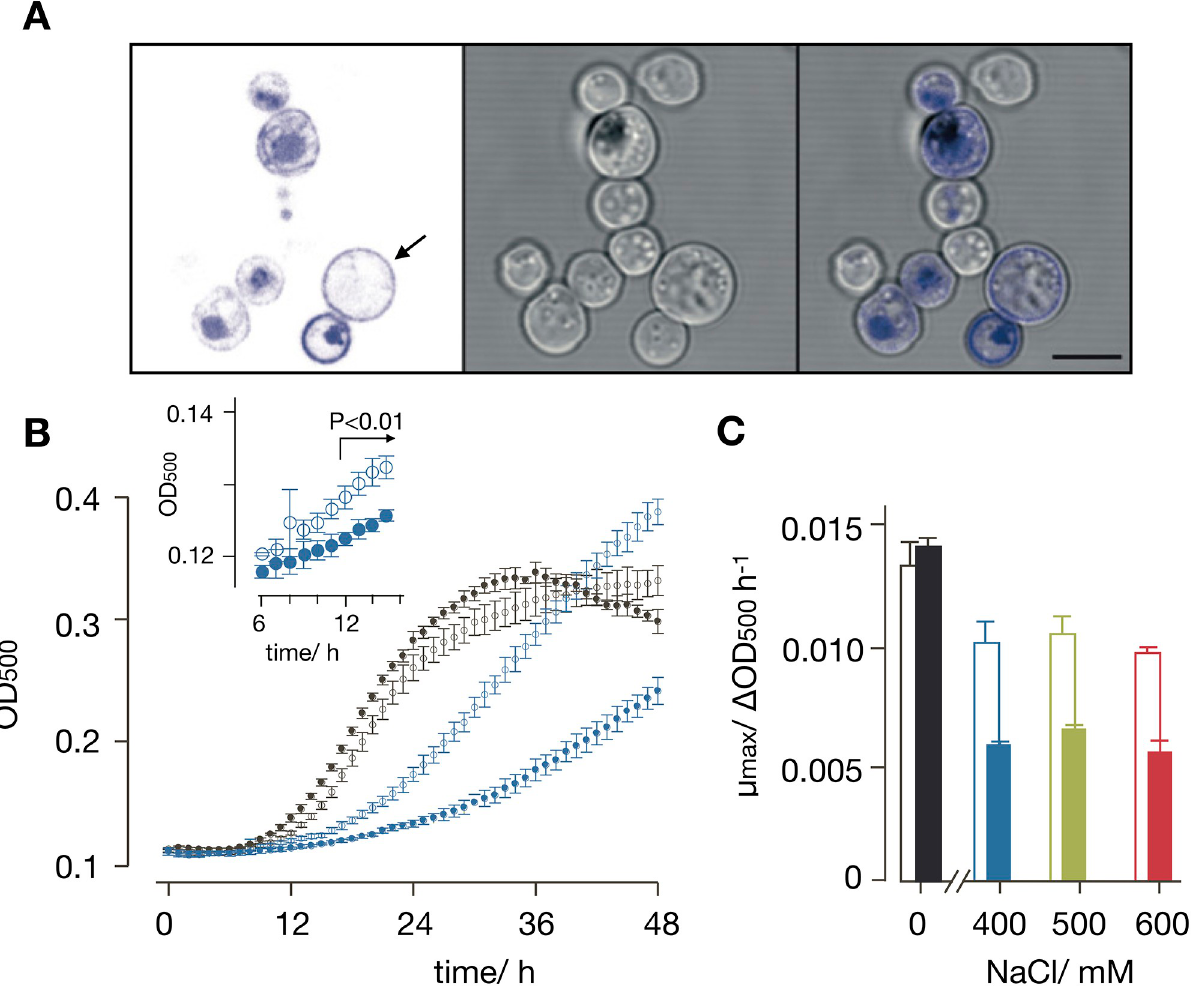
Fig 5. Expression and functional characterization of N/K-ChR2 in SHY4 cells. (A) Fluorescence (left) and transmission light (center) images of SHY4 cells constitutively expressing N/K-ChR2-eYFP. Overlay (right) confirms localization of fluorescent tagged channel (in blue) with endo- membranes and the plasma membrane. The cell indicated by arrow exhibits fluorescence nearly exclusively in plasma membrane. Scale bar = 5 μ m. (B) Growth of SHY4 cells transfected either with empty vector (open symbols) or channelrhodopsin-2 variant (N/K-ChR2, closed symbols) in SD-ura + 10 mM K + medium with 0 (black) or 400 mM NaCl (blue). Growth measured in 30 sec intervals as change in OD 500 . While the presence of N/K-ChR2 has little impact on growth in absence of NaCl it reduces growth in the presence of salt stress. Inset: data in 400 mM NaCl replotted for cells ± N/K-ChR2. After � 12 h cells without N/K-ChR2 grow (P < 0.01) significantly more than controls. (C) Maximum growth rate ( μ max ) from data in B for cells with empty vector (open bars) and with N/K-ChR2 (filled bars) in medium with 0 or 400 mM NaCl. Data are mean ± SD of 3 independent experiments. P values were calculated by student